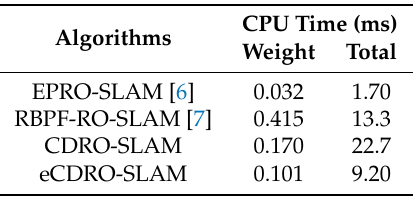
Table 2. Required CPU time for Experiment